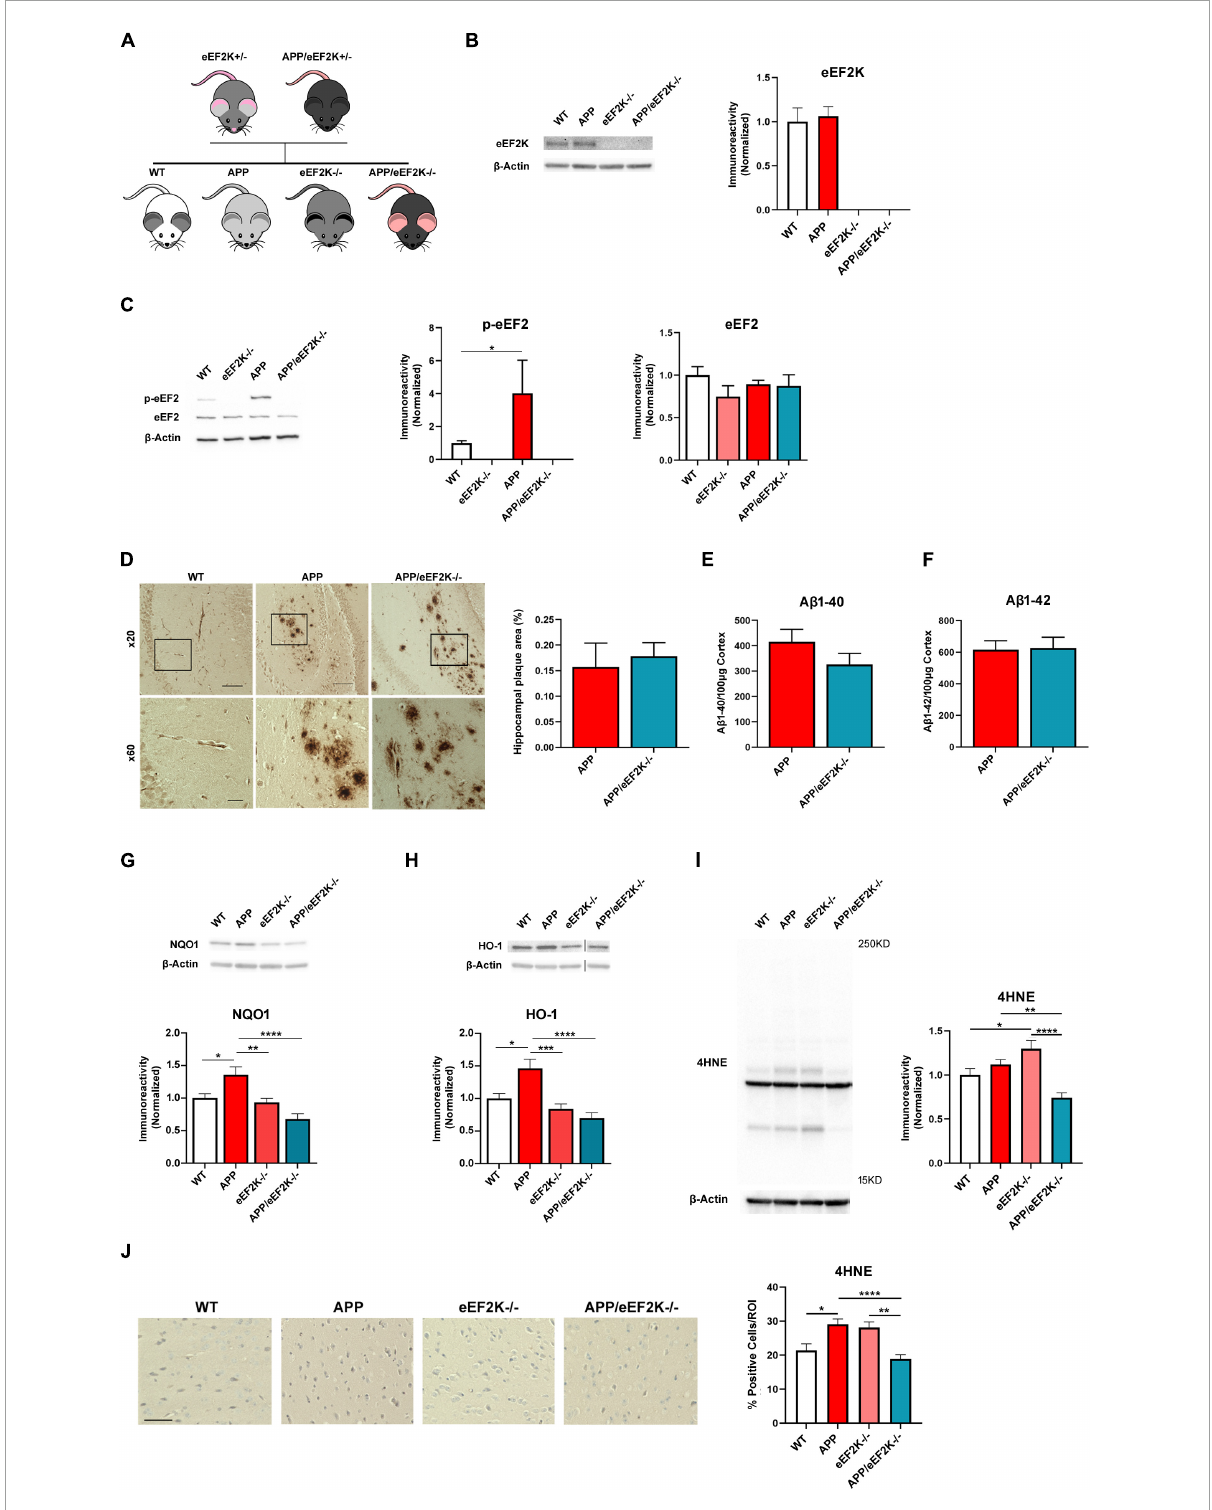
FIGURE1 Homozygous eEF2K knockout alleviates AD-associated eEF2 hyper-phosphorylation and dysregulated NRF2-mediated antioxidant response without affecting amyloid β (A β ) pathology in APP/PS1 mice. (A) Breeding schematic showing generation of APP/eEF2K − / − double mutant mice. (B) Western blot showing eEF2K levels in hippocampal lysates. eEF2K levels depleted in eEF2K − / − and APP/eEF2K − / − mice (WT, n = 4; APP,